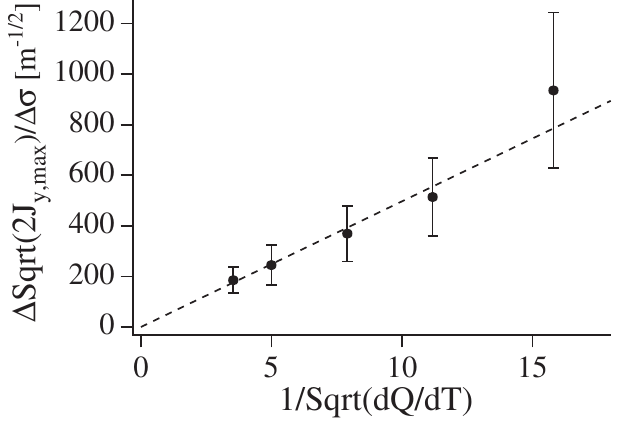
FIG. 4. Amplitude growth as a function of acceleration rate. Error bars indicate rms deviations from the fitted line in Fig.